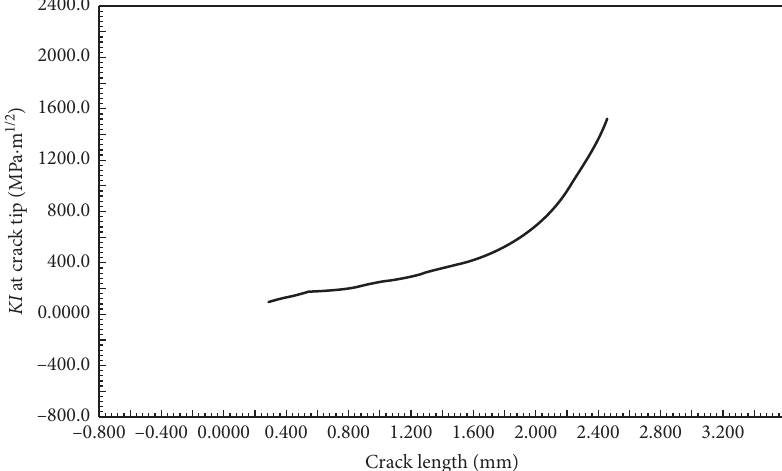
Figure 15: KI values of the fixture at crack tip with respect to crack length.